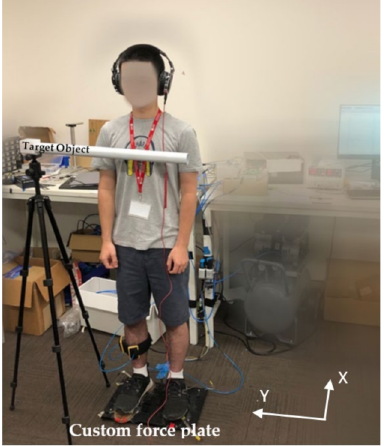
Figure 5. Participant on the custom-built force